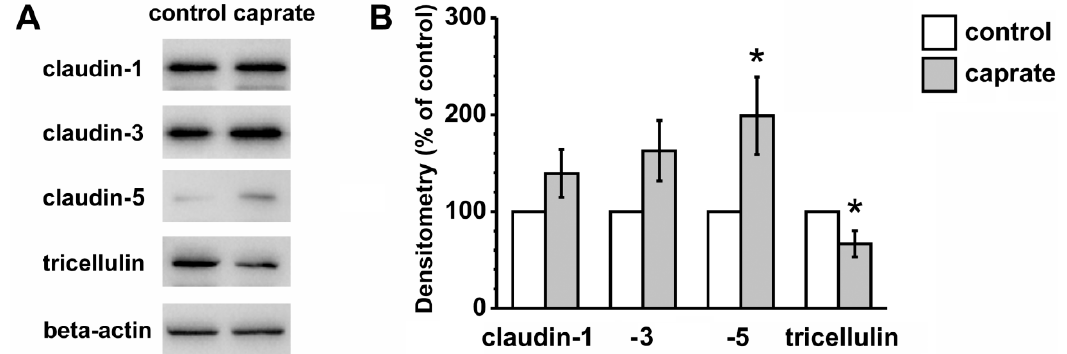
Figure 3 . ( A ) Immunoblots and ( B ) densitometry of TJ proteins in PP tissue (control versus caprate). Densitometric analysis of TJ protein signals after caprate incubation reveals the lower expression of tricellulin, whereas stronger expression of claudin-5 can be detected ( n = 6 – 8, * p < 0.05).